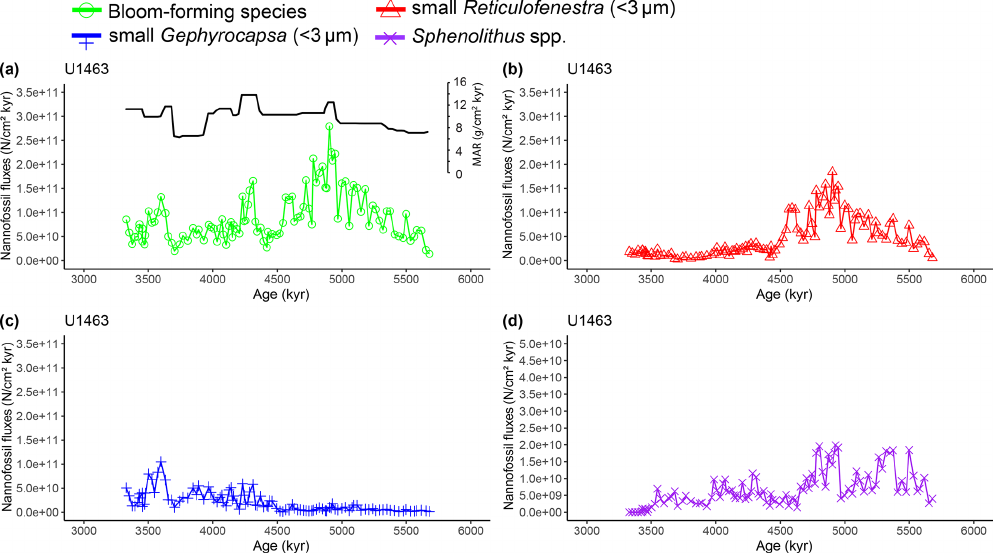
Clim. Past, 19, 765–786, 2023